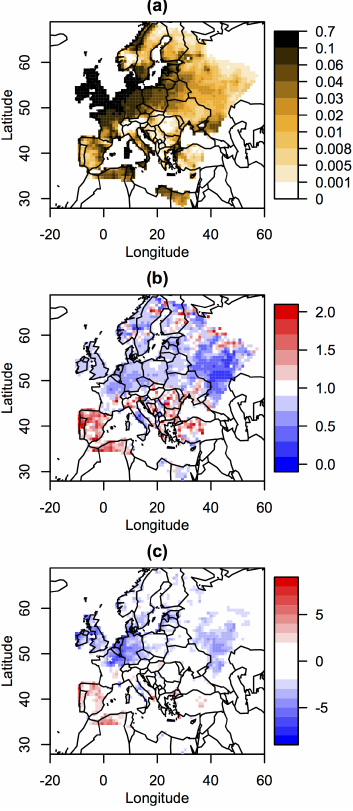
Figure 4. (a) Relative frequency of exceeding 20ms − 1 in the 20th century, F(s j ) , (b) ratio of the relative frequencies in the 21st and 20th centuries, ( F (cid:48) (s j )/F(s j ) ) and (c) the test statistic, t , for the two-sample t test for equal means for the relative frequencies. The grid cell closest to Paris is indicated by a white cross, the location explored in Fig. 5.